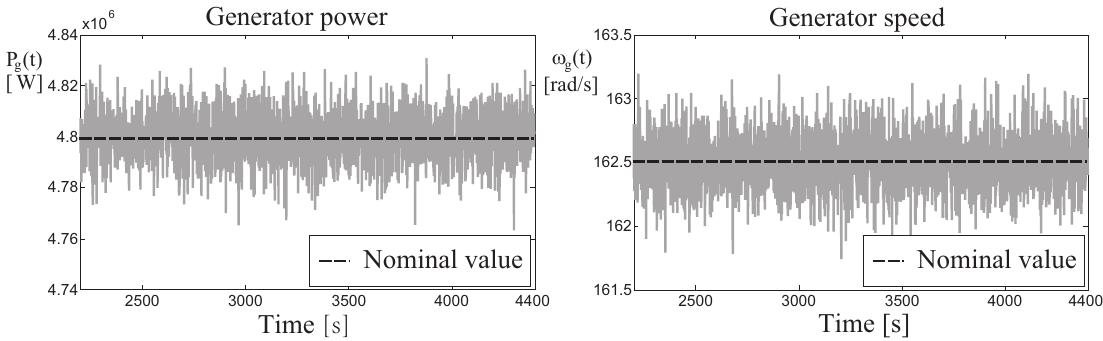
Figure 10. Sensitivity analysis in full load conditions with the data-driven fuzzy